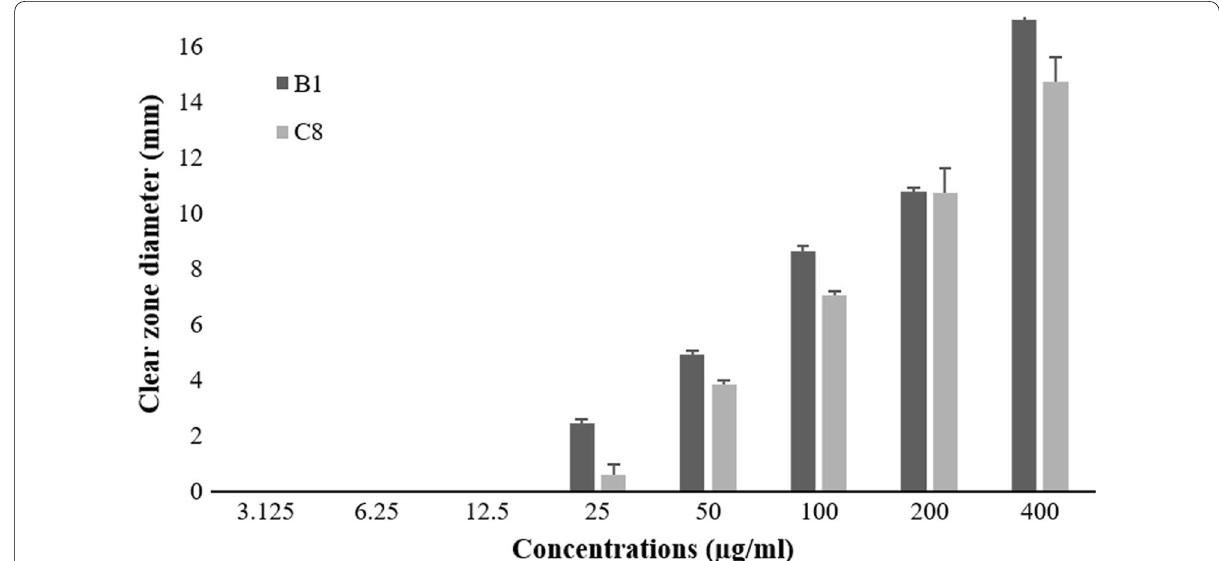
Fig. 4 Minimum inhibitory concentration of the freeze-dried extract of bacterial isolates B1 and C8 cell-free supernatant (CFS) against Xanthomonas citri supsp. citri (XCC)